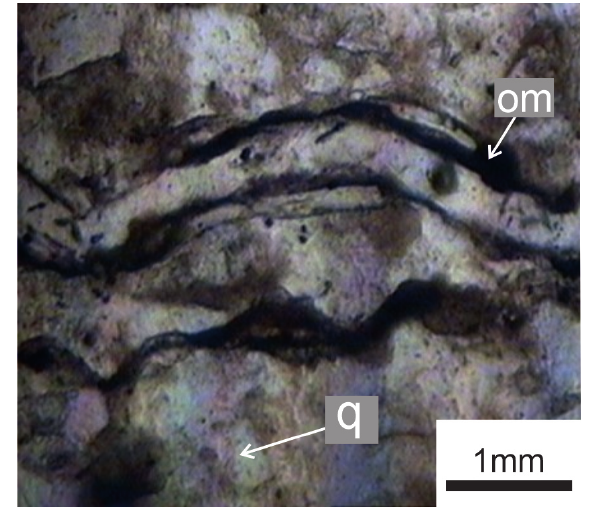
Fig. 9. Photomicrograph of the Ediacaran Kalus Beds sample from the Volyn-Podillyan Plate. Organic-rich clay-rich siltstone from the Sokal-1 borehole, depth interval 3484–3506 m; om, or- ganic matter; q,